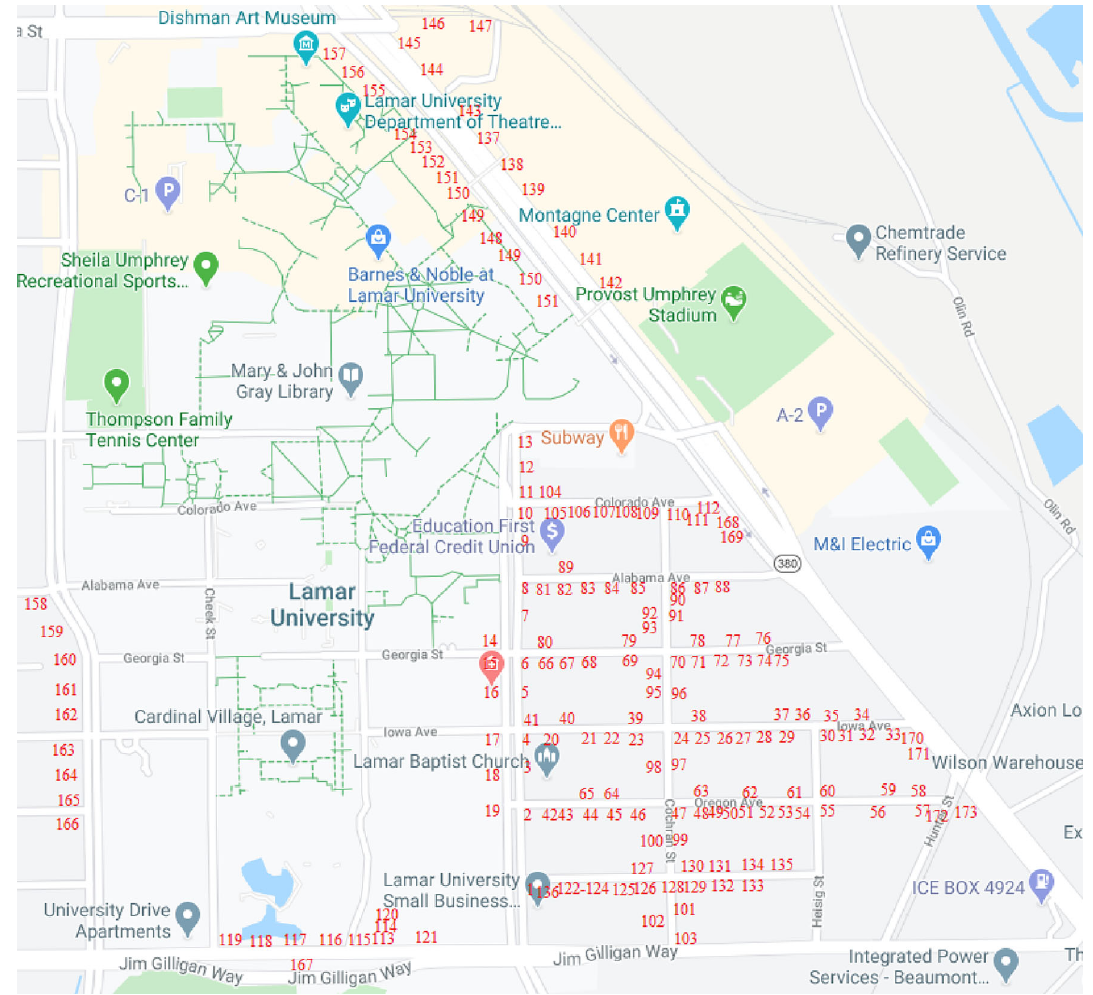
Fig. 5 The selected Beaumont, Texas, case study site and the existing utility poles (labeled as 1–173). Source : Google Maps, Google, Inc., February